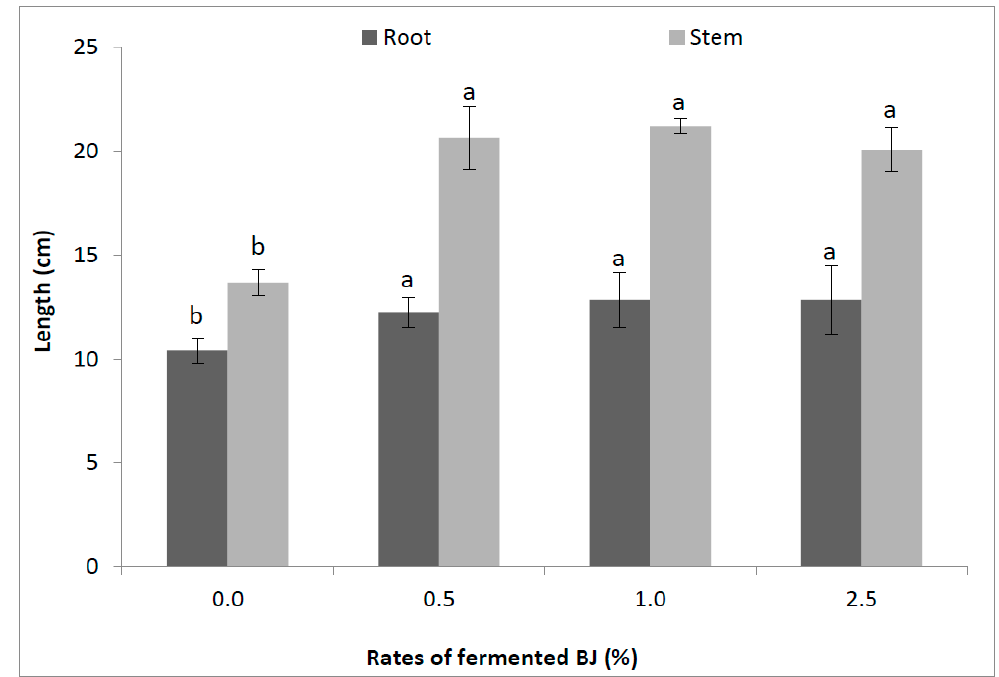
Figure 1. Root and stem length of sweet basil plants treated with different rates of fermented BJ. Sample size n = 6 (mean ± SD). Different letters above the same columns show significant differences at the level of p ≤ 0.05.